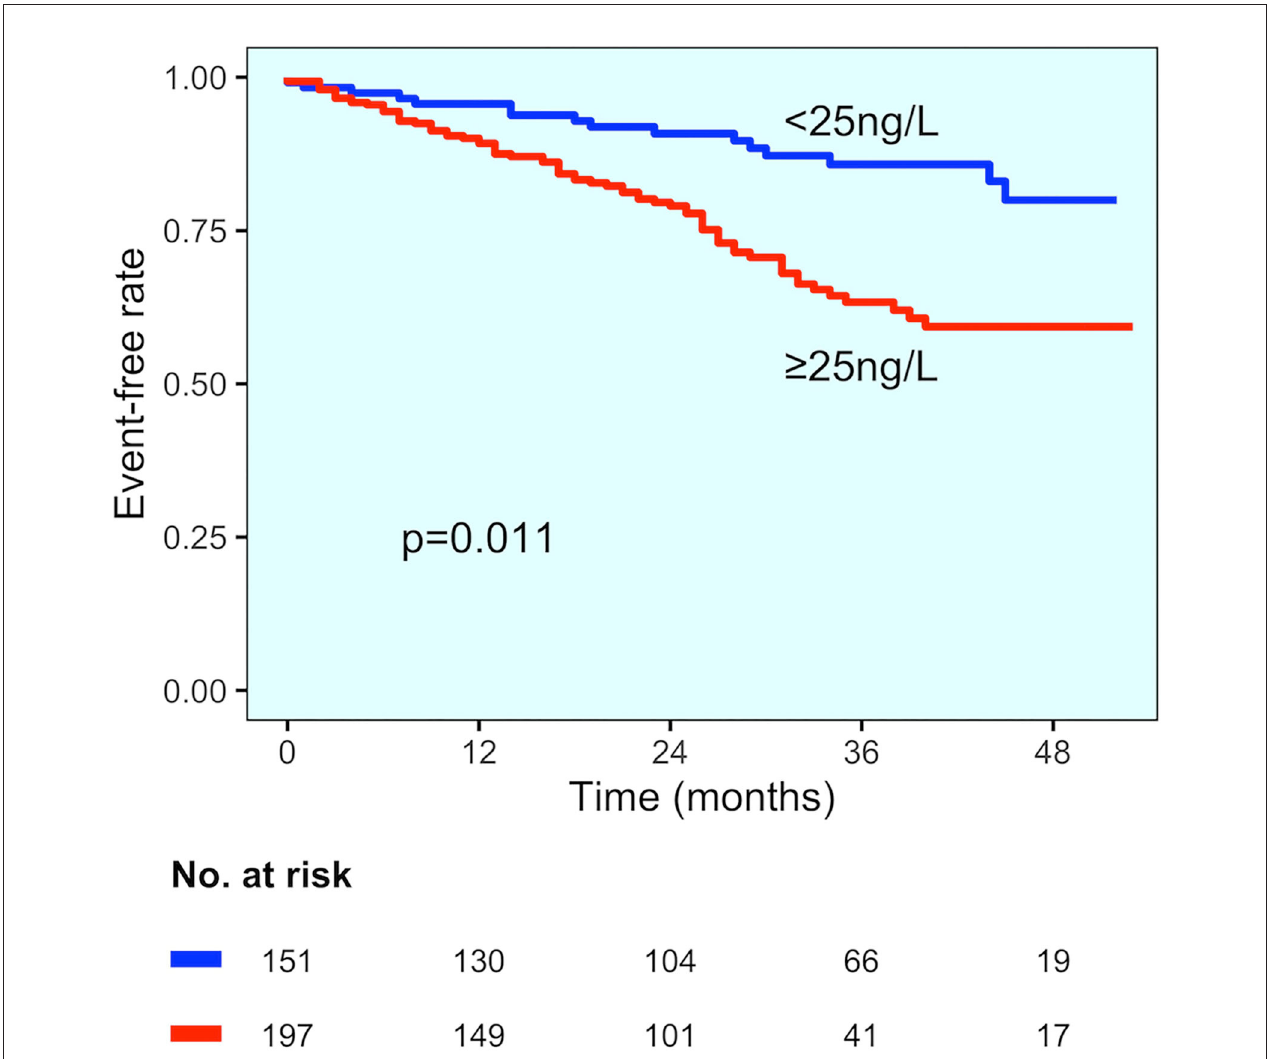
FIGURE 4 | MACE incidence in the no CAD diagnosis group. Kaplan–Meier curves for MACE in patients with no CAD diagnosis, stratified by hs-TnT cut-off (25